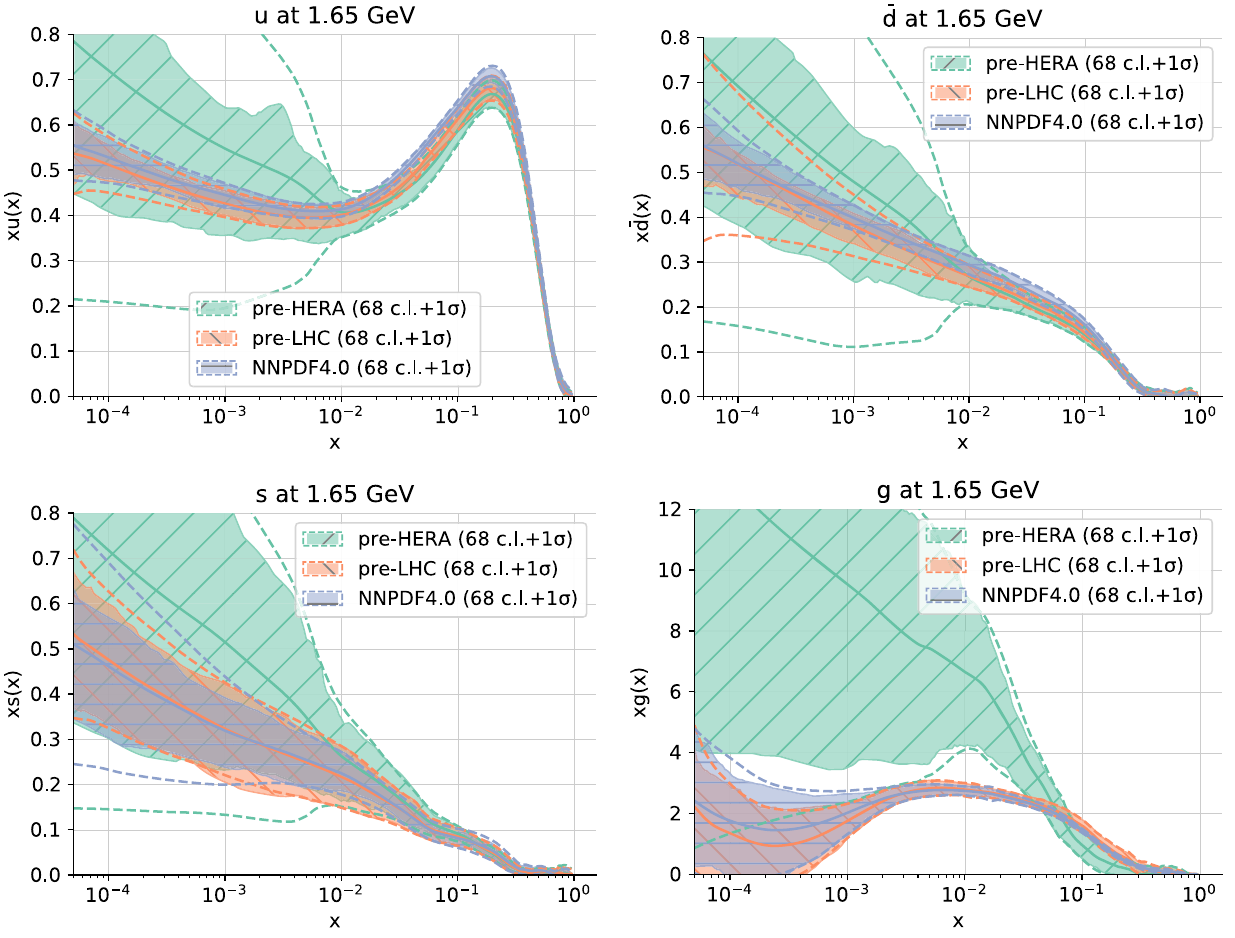
Fig. 28 Some pre-HERA and pre-LHC PDFs compared to PDFs based on full NNPDF4.0 dataset, in all cases obtained using the NNPDF3.1 fitting methodology. The up (top left), antidown (top right), strange (bottom left) and gluon (bottom right) are shown at the input parametrization scale of Q = 1 . 65